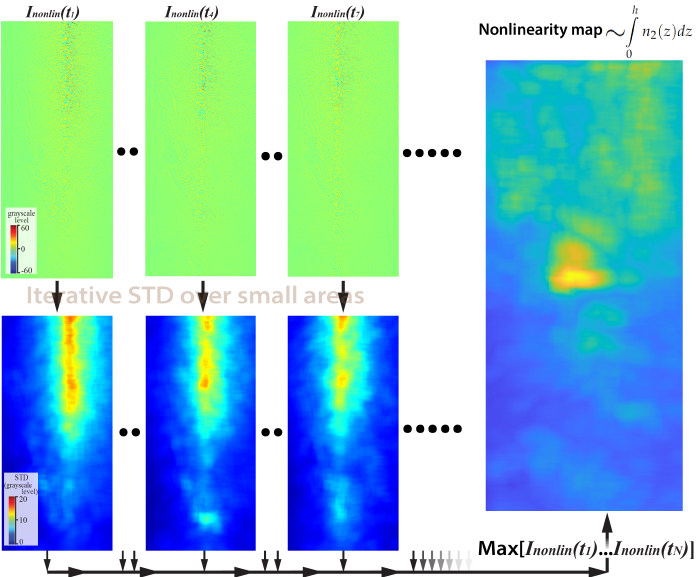
Figure 4. The top row demonstrates diffraction patterns induced by the femtosecond probe pulse NDPM. The bottom row shows several typical nonlinearity “maps” obtained for different pump pulse delay values. The final nonlinearity “map”, estimated from their combined analysis, is shown in the right part of the